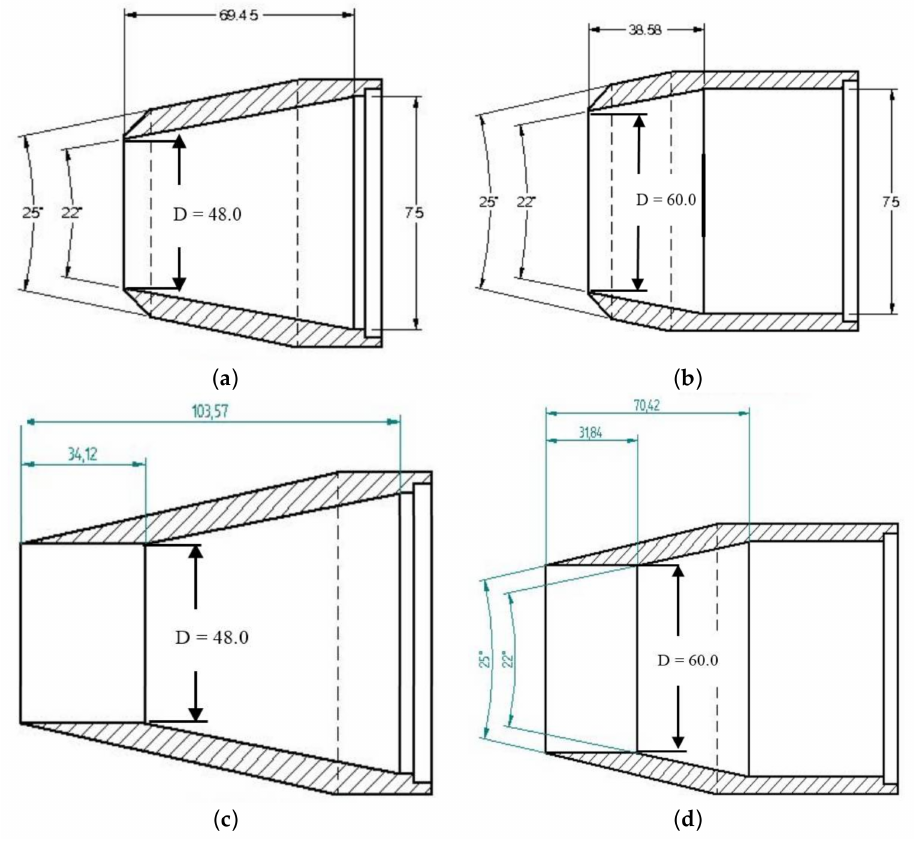
Figure 2. Axisymmetric convergent test nozzles (dimensions in mm); D is nozzle exit diameter. ( a ) LU48; ( b ) LU60; ( c ) LU48P; ( d )